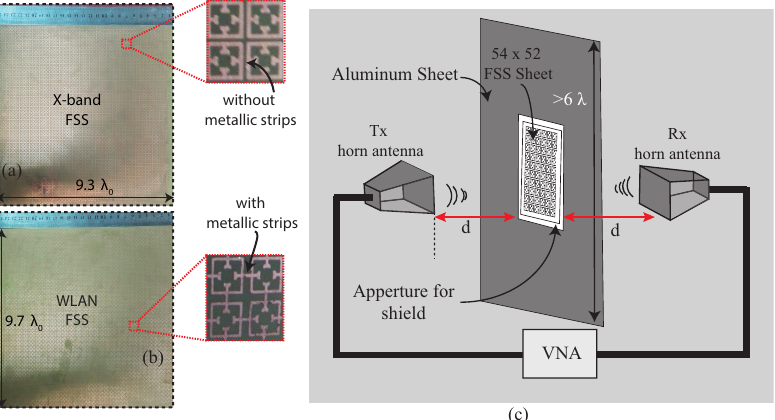
Figure 10. FSSs fabricated with 54 × 52 unit cells on a 260 mm × 250 mm FR4 board: ( a ) FSS without metallic strips for the X-band shielding and ( b ) FSS with metallic strips for C-band shielding. ( c ) Illustration of the experimental setup for all